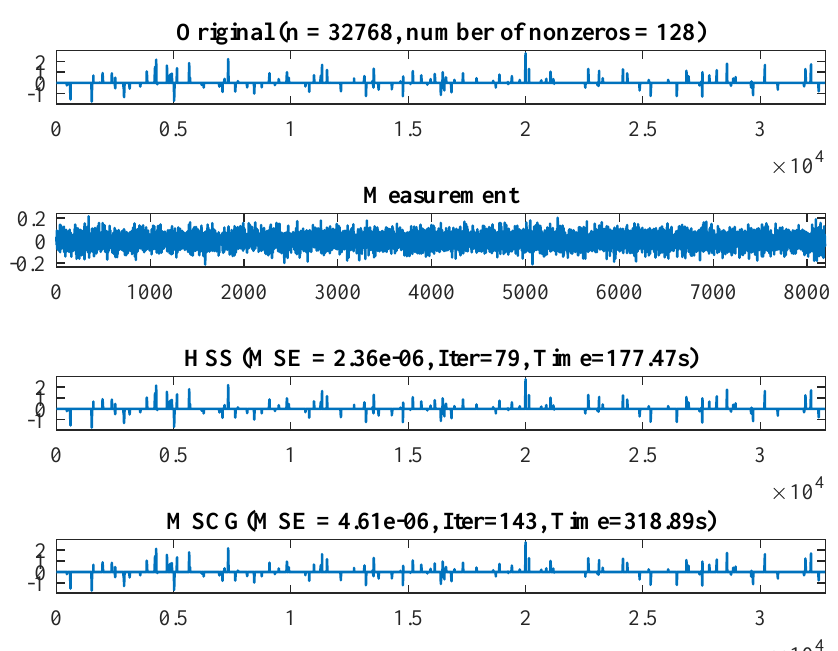
Figure 4. From top to bottom: the original signal, the measurement, the recovered signal by HSS and the recovered signal by MSCG.